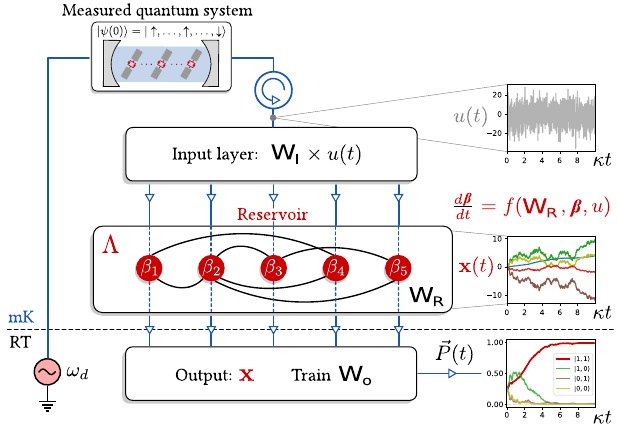
FIG. 2. A schematic of our proposal to use a hardware RC to process quantum measurement signals, here shown for K ¼ 5 Kerr nodes. The QS is interrogated, and the resulting measure- ment current u ð t Þ is input to the reservoir. The input layer W randomly couples this signal to each node of the Kerr network, whose subsequent dynamics are a nonlinear function of u ð t Þ and the network itself via Eq. (8). The output layer performs classification by learning linear combinations of measured reservoir variables x which extract the probability that the input history corresponds to a given underlying quantum